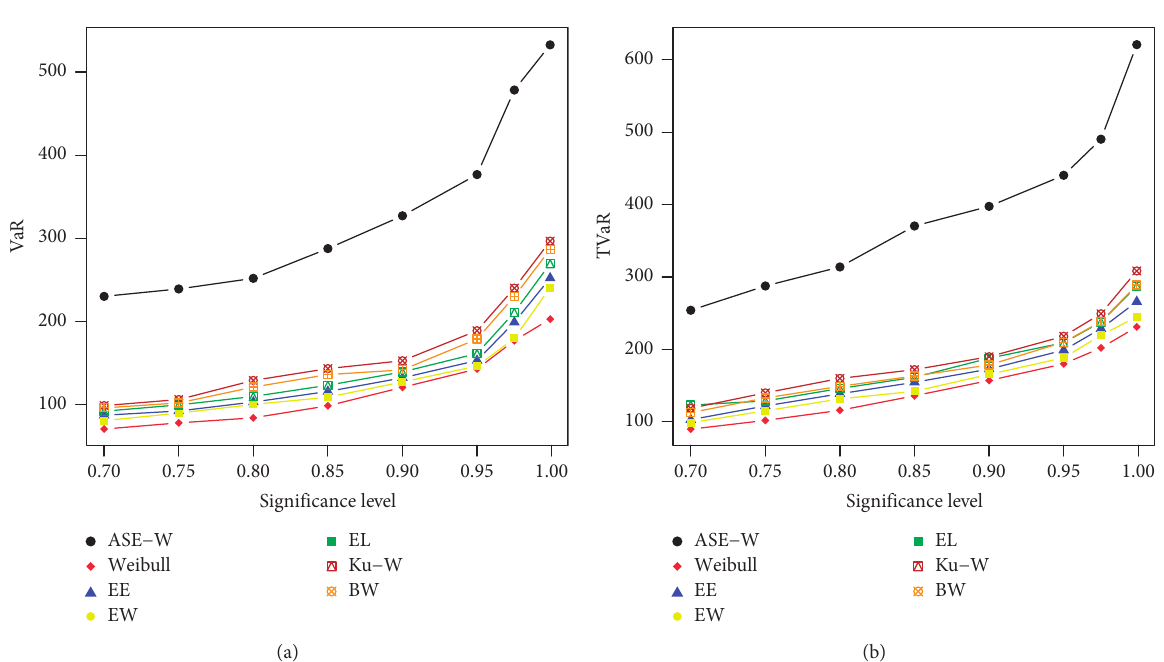
Figure 10: Graphical sketching of the VaR and TVaR using the results in Table 10 for insurance claims